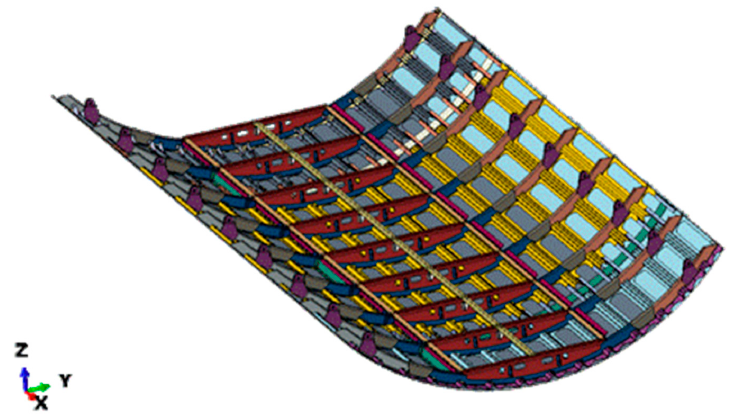
Figure 3. Subsection cargo floor.